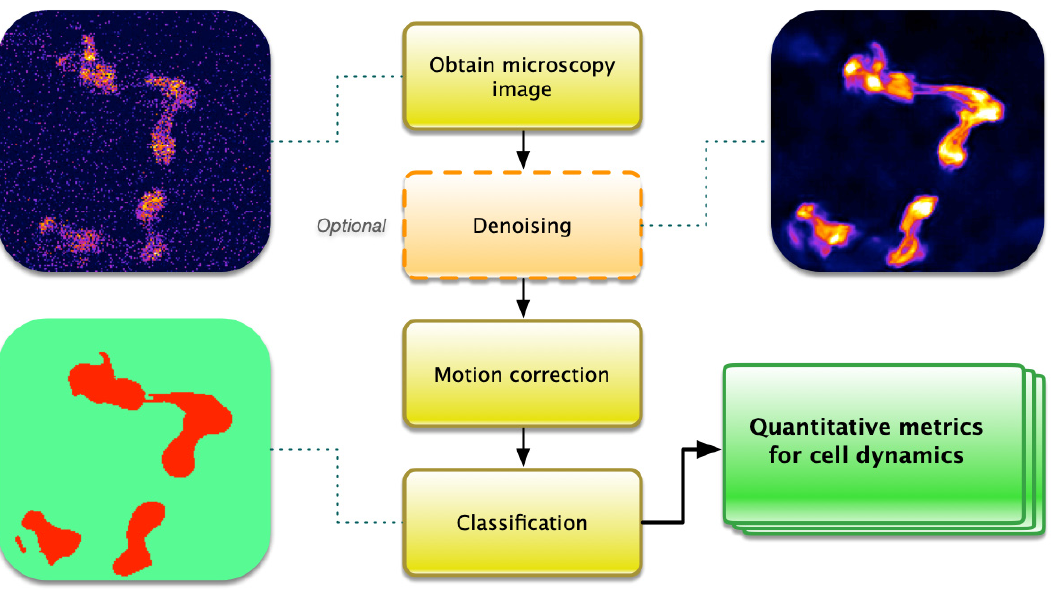
Figure 1. The steps of a common pipeline for calcium imaging analysis can be subdivided into three areas before quantitative analysis is performed. Denoising is an optional step that can help to improve signal-to-noise and enhance features. Motion